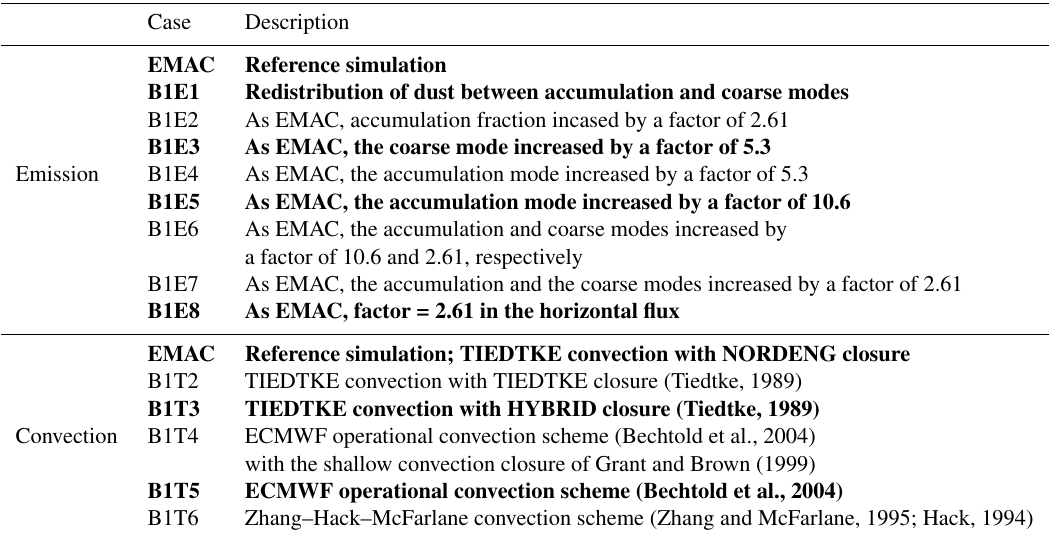
Figure 6. Time series of size-resolved surface dust concentrations for the different AERONET stations shown in Fig. 3. The aerosol modes are accumulation soluble (as), coarse soluble (cs), accumulation insoluble (ai) and coarse insoluble (ci). Note the different scaling, which reflects the wide range of concentrations at these stations. The accumulation mode dust fraction has a much lower contribution to the total dust concentration. Table 3. A description of the transatlantic dust transport sensitivity simulations for two key processes: (i) emission flux (Sect. 4.1) and (ii) convection scheme (Sect. 4.2). The highlighted cases are shown in the paper (for all cases, see the Supplement, Figs. S3–S4). The emitted dust mass in July 2009 for the reference case is 0.6133kgm − 2